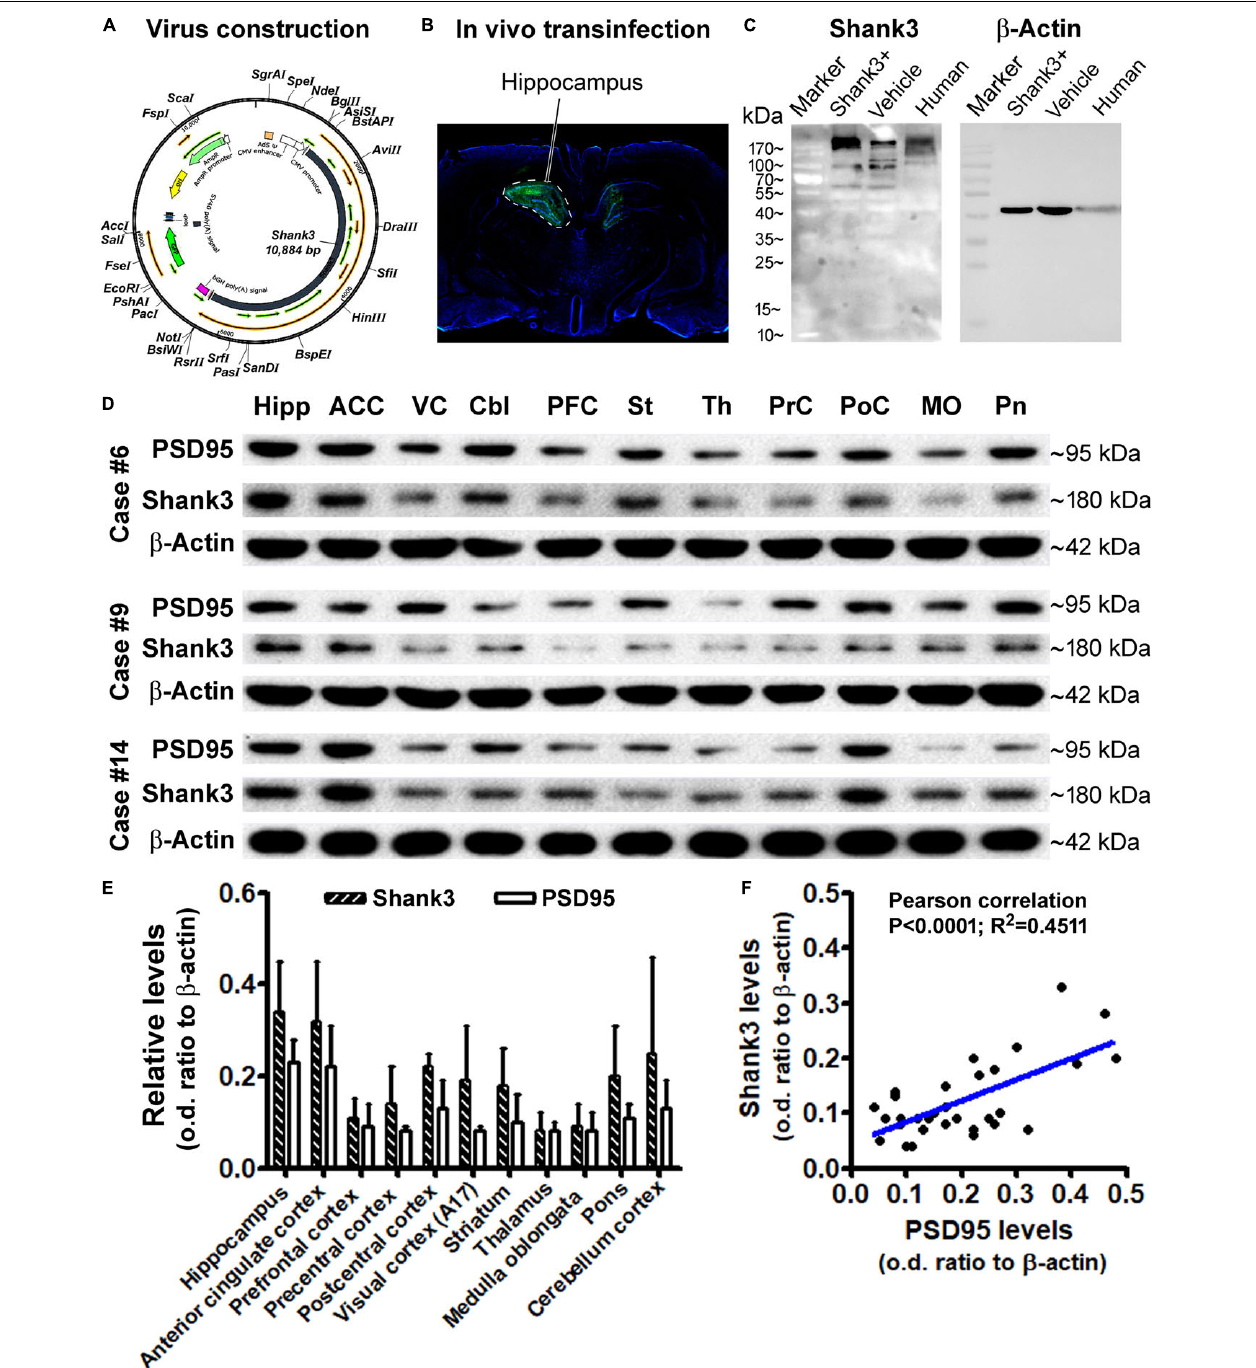
FIGURE 10 | Western blot characterization of the Shank3 antibody and assessment of the Shank3 protein levels in representative brain regions. (A) Schematically illustrates the adenovirus genomic structure, including manipulating apparatus and the human SHANK3 cDNA. (B) shows an example of in vivo infection in the rat hippocampus 30 days post unilateral stereotactical injection of the constructed virus. (C) shows a representative immunoblot image, illustrating the relative levels of Shank3 protein in the hippocampal lysates from rats infected with the constructed virus (Shank+) and vehicle virus, and postmortem human brain. The major immunoblotted products migrate at ∼ 180 kDa in all samples; several light bands also migrated from 90 to 180 kDa, with an apparently greater amount in the Shank + transinfected sample. (D) shows immunoblotted products of Shank3, PSD95, and β -actin (internal loading control) in lysates from different brain regions from three cases, as indicated. (E) Plots the relative levels of Shank3 and PSD95, expressed as optic density (o.d.) ratios normalized to internal control across regions. (F) shows a positive correlation between Shank3 and PSD95 levels based on the multi-region and multi-case immunoblotting data. Abbreviations of brain regions in (D) are as indicated correspondingly in (E)